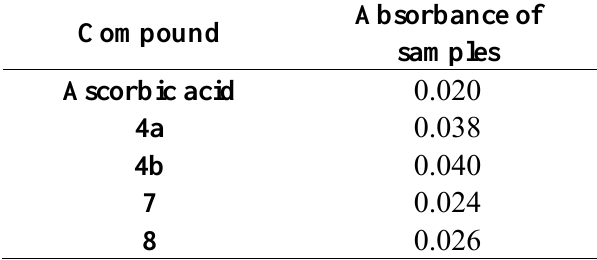
Table 4. Assays for bleomycin-dependent DNA